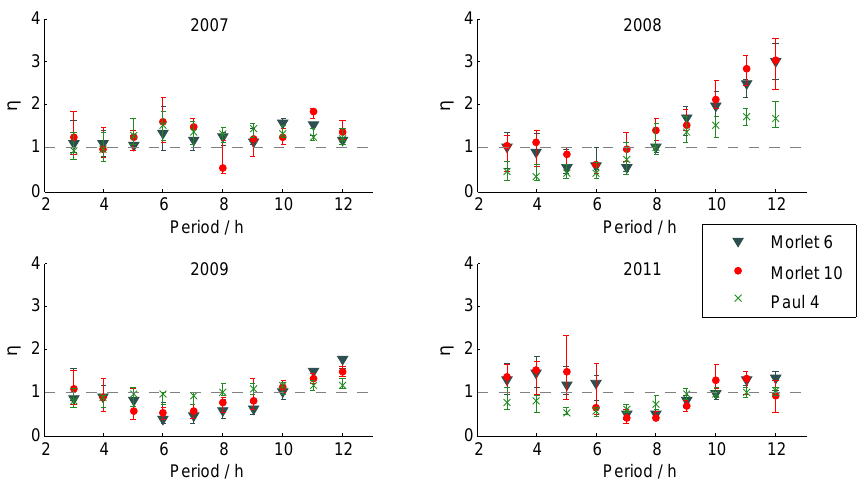
Fig. 5. Ratio η (see Eq. 3) for the years 2007, 2008, 2009 and 2011 and three different mother wavelet functions (Morlet with parameter ω 0 = 6 and ω 0 = 10 and Paul of order m = 4). The errorbars result from variation of the raw data within its